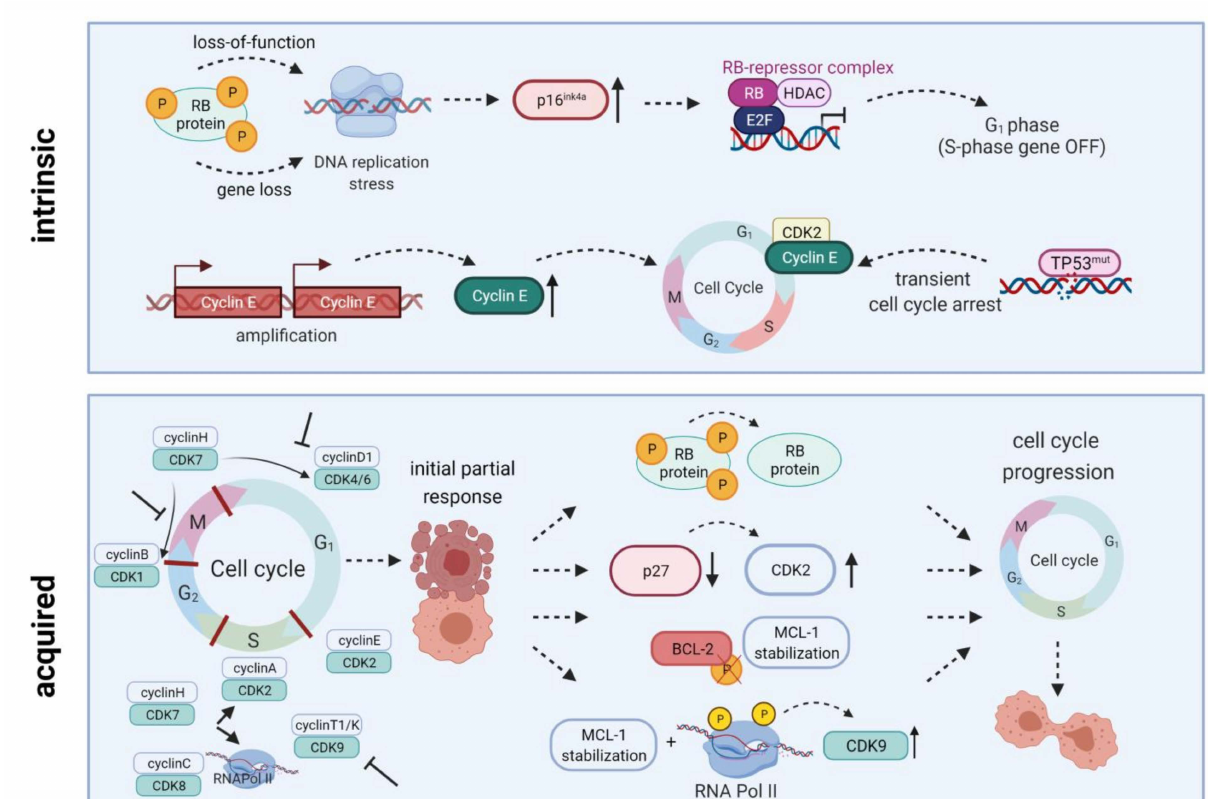
Figure 2. Intrinsic and acquired resistance mechanisms towards CDKIs. Intrinsic resistance is driven by lack of functional Rb protein, leading to DNA replication stress, high-level expression of endogenous CDK4/6 inhibitor p16 INK4A , and inactivation of E2F-regulated genes. Another resistance mechanism is based on Cyclin E amplification and overexpression driving cell cycle progression. Quite in line, TP53 mutations are generally associated with low response to CDK inhibition. Acquired resistance mechanisms include Rb loss, CDK2 reactivation upon p27 downregulation, a truncated BCL-2 protein lacking the phosphorylation loop domain, as well as prolonged MCL-1 stability along with RNA polymerase II phosphorylation and CDK9 kinase domain up-regulation. All these mechanisms may ultimately contribute to cell cycle progression and thus CDKI resistance. HDAC, histone deacetylase; E2F, E2F transcription factor family; RNA Pol II, RNA polymerase II. Created with